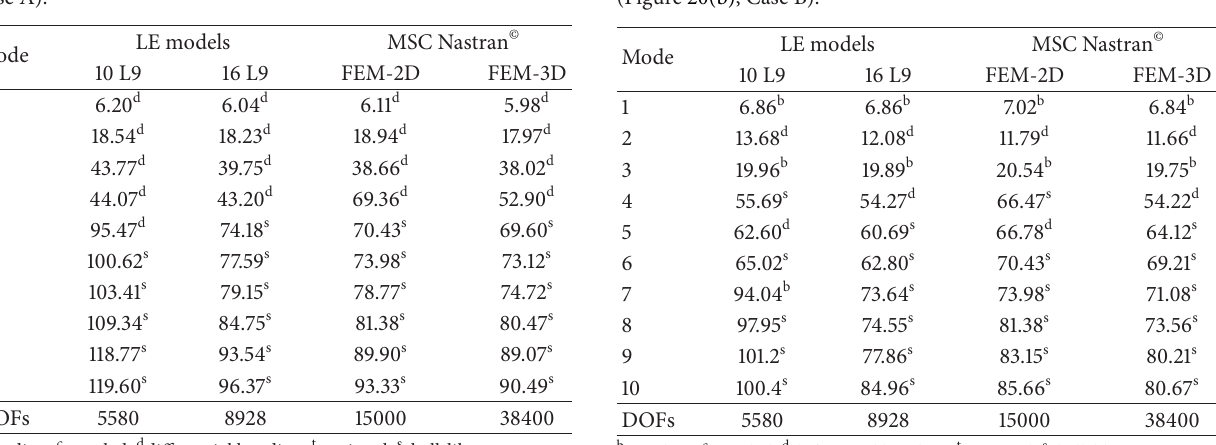
Table7:First 10 naturalfrequencies(Hz)forthehollow-rectangular boxbeamwithlocalizedinertiaatthetipcross-section(Figure20(a), Case A).